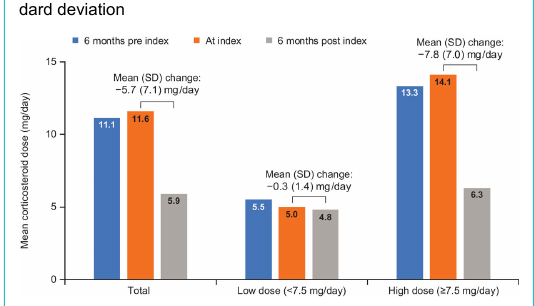
Figure 2: Change in oral corticosteroid use among patients who received corticosteroids by initial dosage group (n = 42). SD, stan- dard